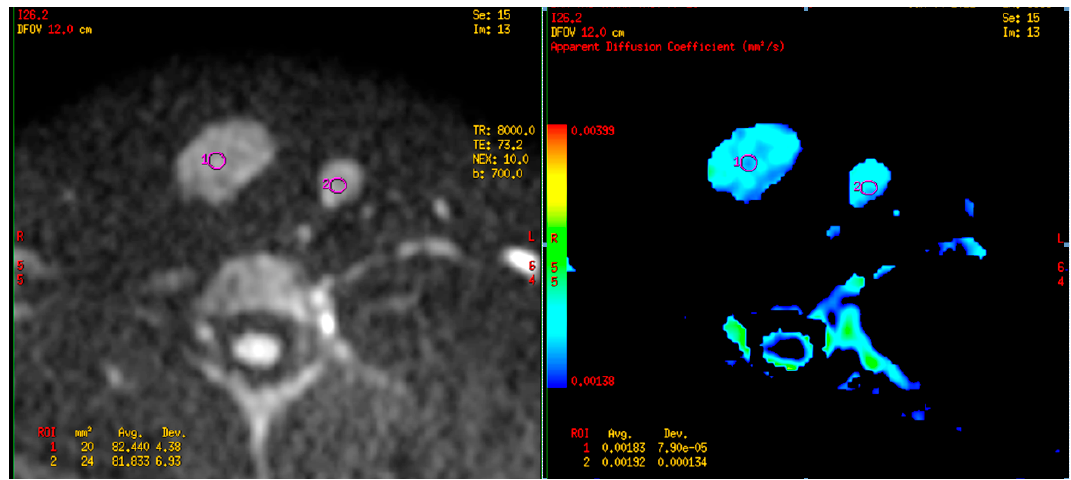
Figure 4. Right and left lobe thyroid nodules, with b = 700, ADC: 1.83 × 10 − 3 mm 2 /s and 1.92 × 10 − 3 mm 2 /s. Histopathology result: benign nodules.